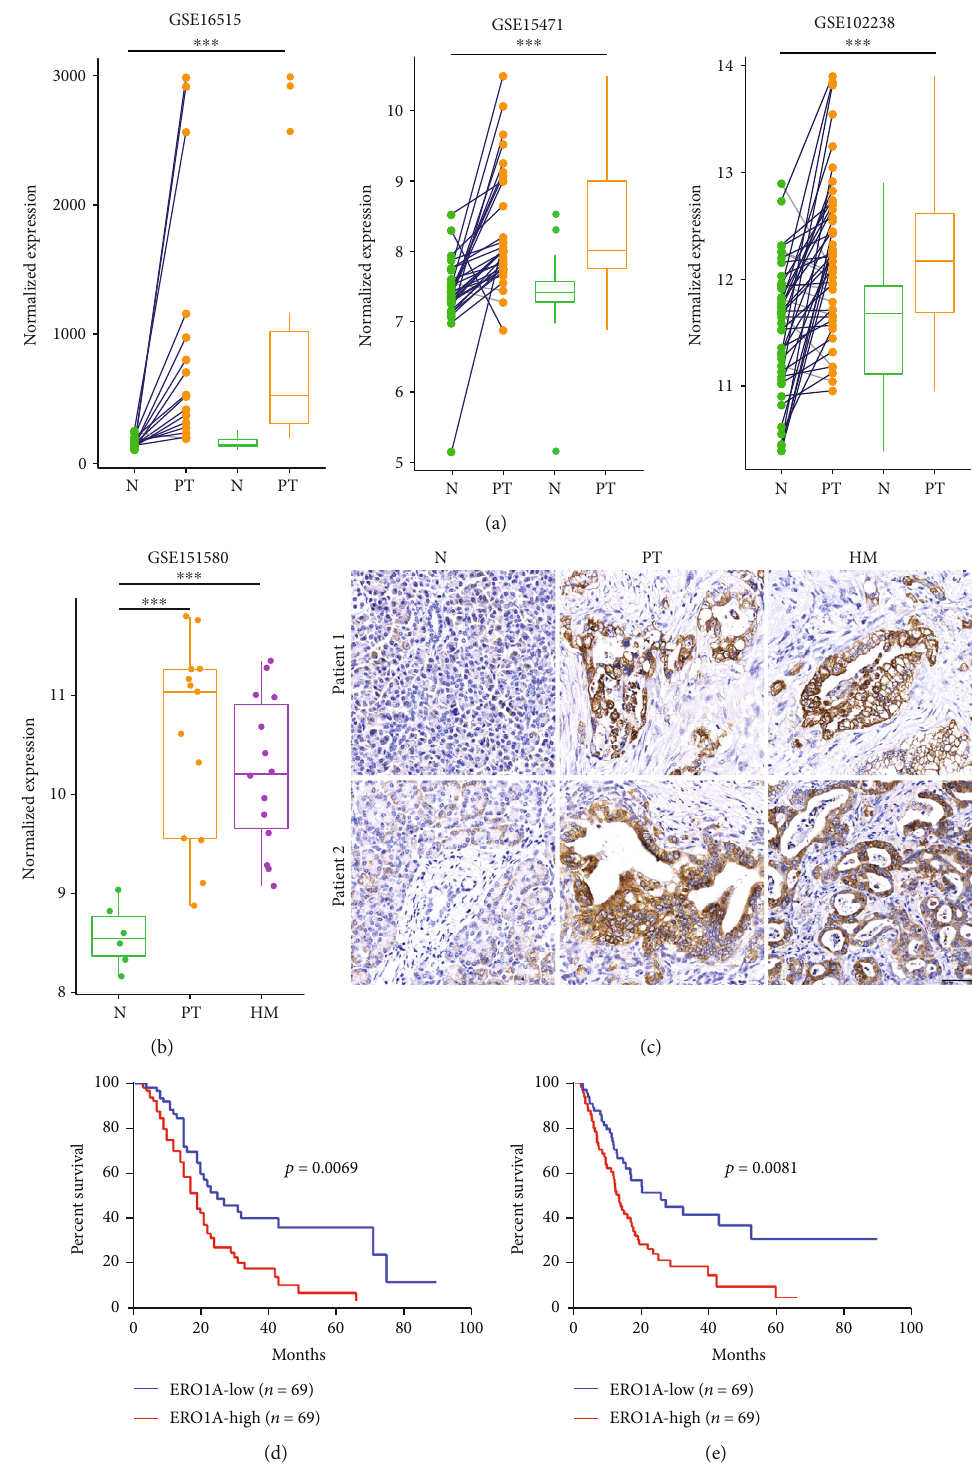
Figure 1: ERO1L is overexpressed in metastatic PDAC and predicts a poor prognosis. (a) The expression pattern of ERO1L in paired samples of three independent PDAC cohorts using GSE16515 ( n = 16 , P = 0 : 002752 ), GSE15471 ( n = 33 , P = 4 : 513 e − 06 ), and GSE102238 ( n = 47 , P = 6 : 582 e − 07 ). Data were derived from the GEO database. (b) The expression pattern of ERO1L in hepatic metastatic PDAC cohort using GSE151580 ( n = 47 , P = 2 : 309 e − 06 ). Data were derived from the GEO database. (c) Representative images of ERO1L protein expression in two hepatic metastatic PDAC patients; Scale bar: 50 μ m. (d) Kaplan-Meier survival curves showing the overall survival of PDAC patients based on ERO1L expression in TCGA-PAAD datasets (log-rank test, P = 0 : 0069 ). (e) Kaplan-Meier survival curves showing the disease-free survival of PDAC patients based on ERO1L expression in TCGA-PAAD datasets (log-rank test, P = 0 : 0081